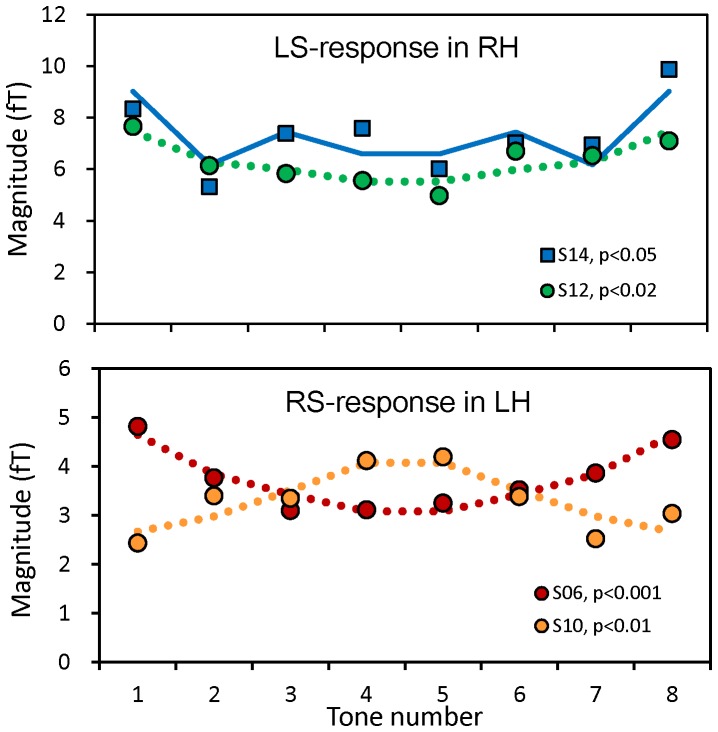
Magnitudes of ASSR as functions of tone number observed in (a) LS response in the RH and (b) RS response in the LH.Subjects belonged to the ILL (S12) and STM (S14) groups in (a) and to the ILL group (S06, S10) in (b). P-values are the significance levels of STM-type (square symbols) and ILL-type (circle symbols) regression coefficients obtained from multiple regression analysis. Synthesized variations using the regression coefficients are shown by the lines connecting calculated values.